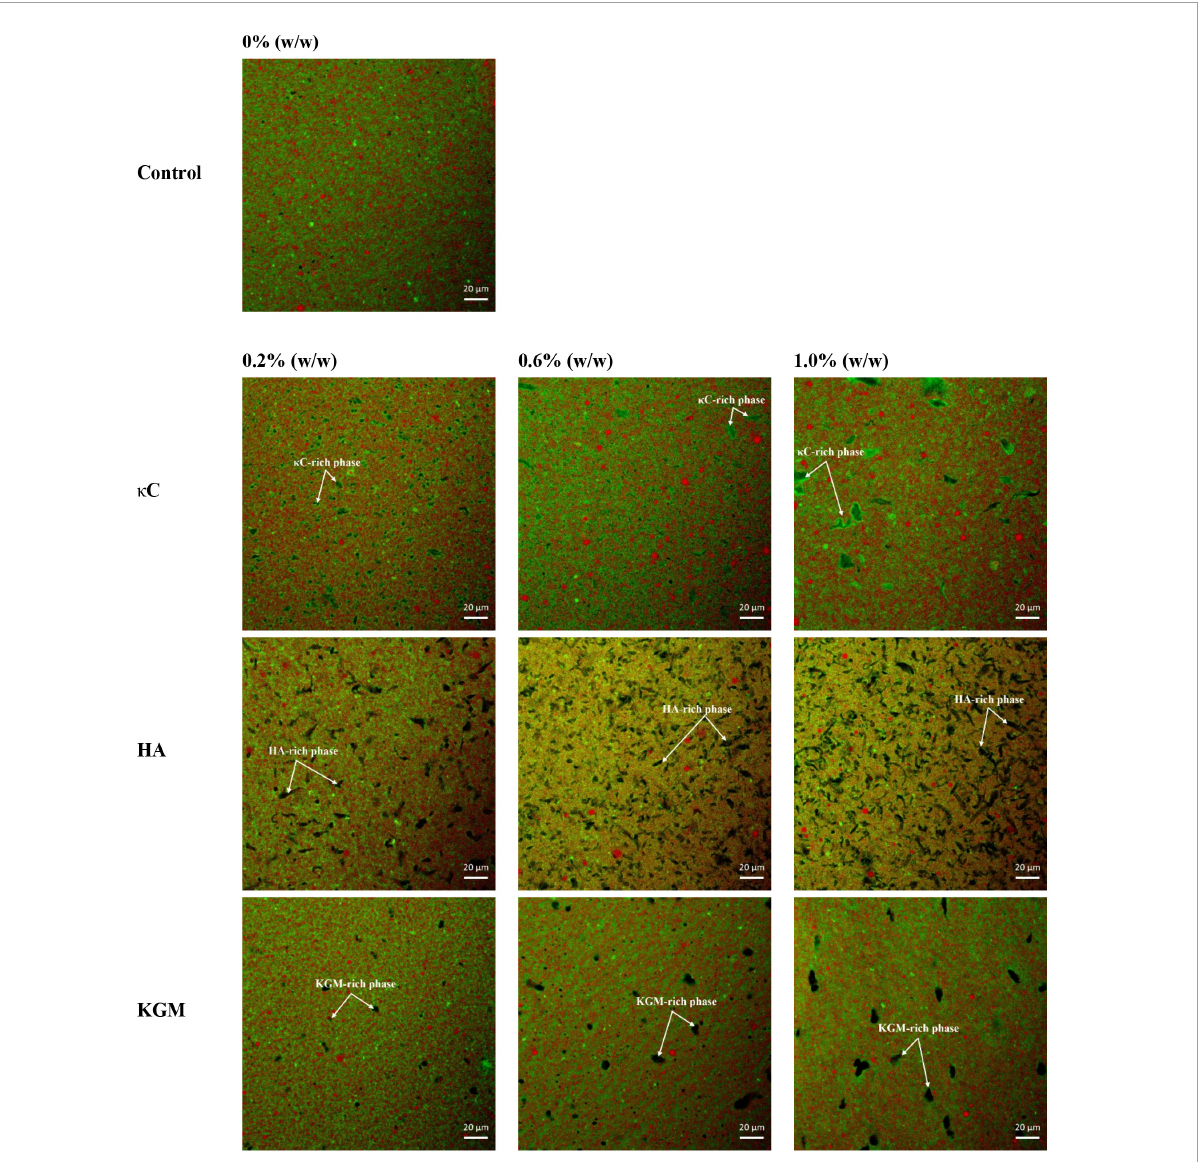
FIGURE6 Confocal laser scanning microscopy (CLSM) images of emulsion gels containing different polysaccharides. Scale bar is 20 µ m. κ C, κ -carrageenan; HA, high-acyl gellan; KGM, konjac